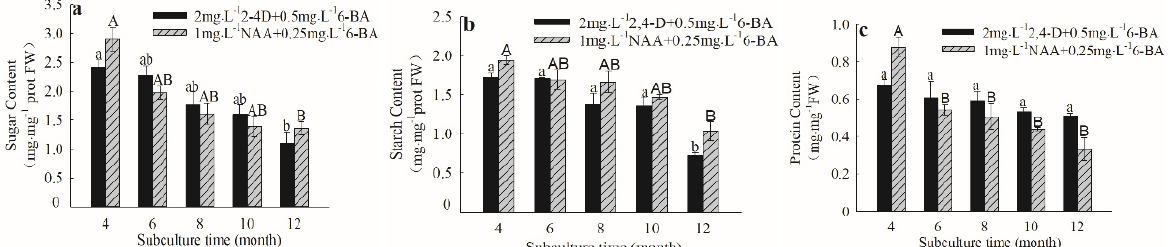
Figure 4. Effects of subculture cycle and hormone ratio on storage substances in embryogenic calli of Pinus koraiensis during long-term subculture. ( a ) Sugar content in callus with different hormone ratios, ( b ) Starch content in callus with different hormone ratios, ( c ) The content of callus protein with different hormone ratios; Note: Different letters (upper or lower case) in the table indicate significant differences between columns (Duncan’s multiple range test; p = 0.05). Effect of carbon source on stored material content On the medium with sucrose as the carbon source, the maximum soluble sugar con- tent of embryogenic callus was 2.41 mg·mg − 1 prot in the 4th month of subculture. On the